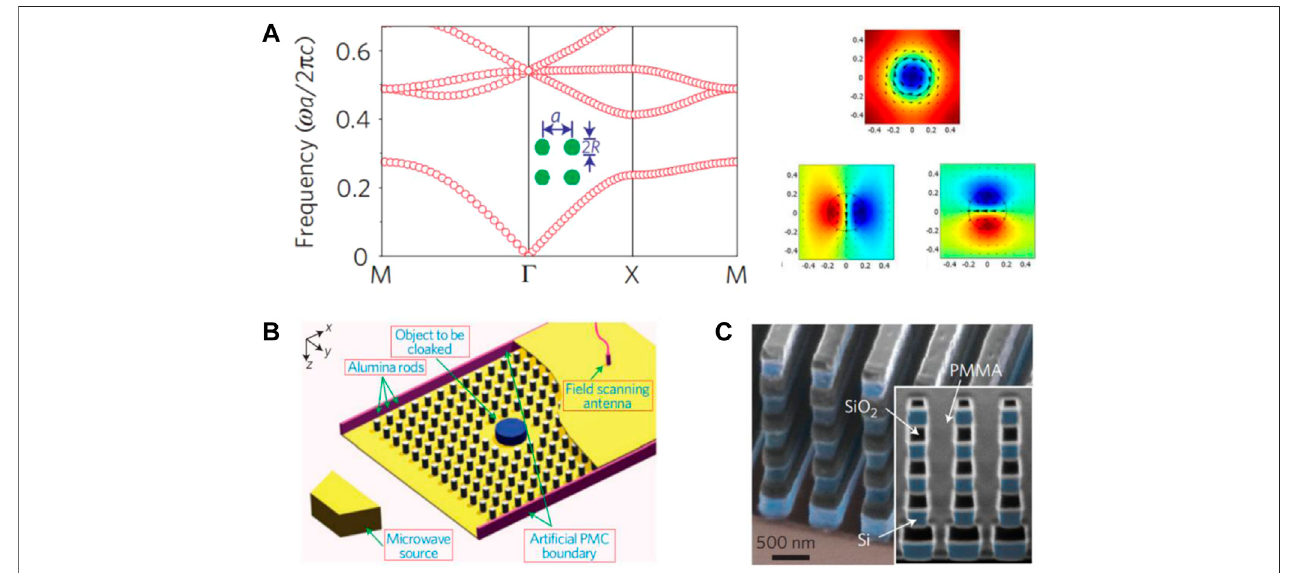
FIGURE 1 | (A) The band structure of a PhC consisting of a square lattice of dielectric rods. Two branches with linear dispersion intersect at a triply-degenerate point at the Γ point, forming a Dirac-like cone. The right panel shows the distributions of out-of-plane electric fi elds (color) and in-plane magnetic fi elds (arrows) of the eigenstatesneartheDirac-likepoint. (B) ThePhCwithaDirac-likeconewasexperimentallydemonstratedinthemicrowaveregimeusingasquarearrayofaluminarods. Reproduced with permission from Ref. [32]. (C) A PhC consisting of horizontal square array of silicon bars was demonstrated to exhibit the Dirac-like cone in the infrared regime. Reproduced with permission from Ref.